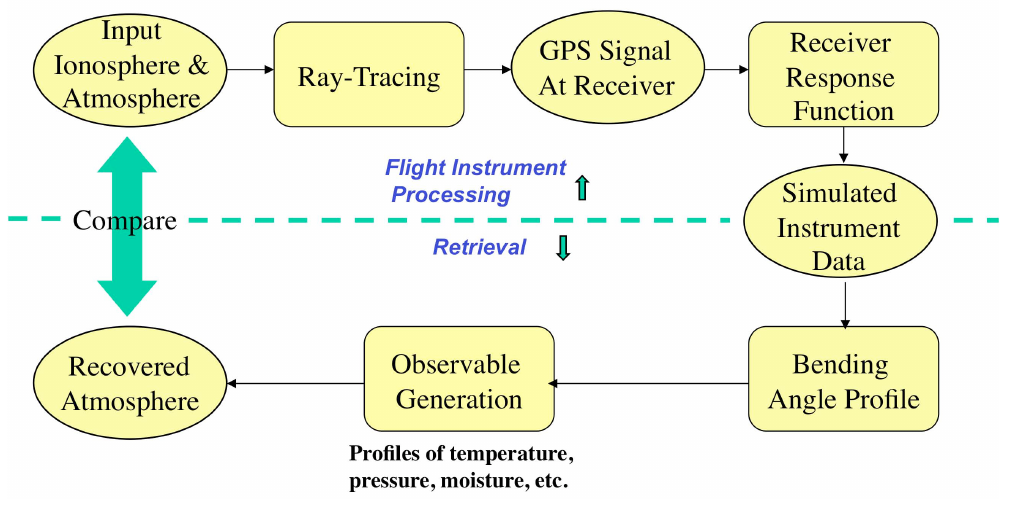
Fig. 11. Processing chain for the end-to-end